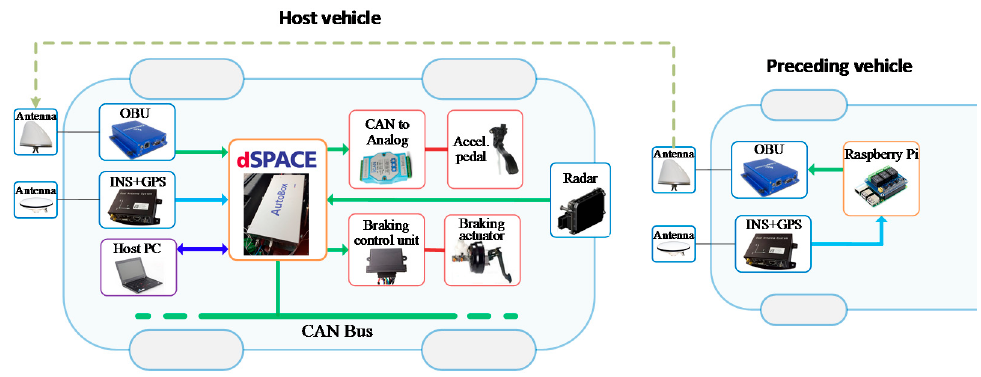
Figure 2. Functional architecture of the test platform.